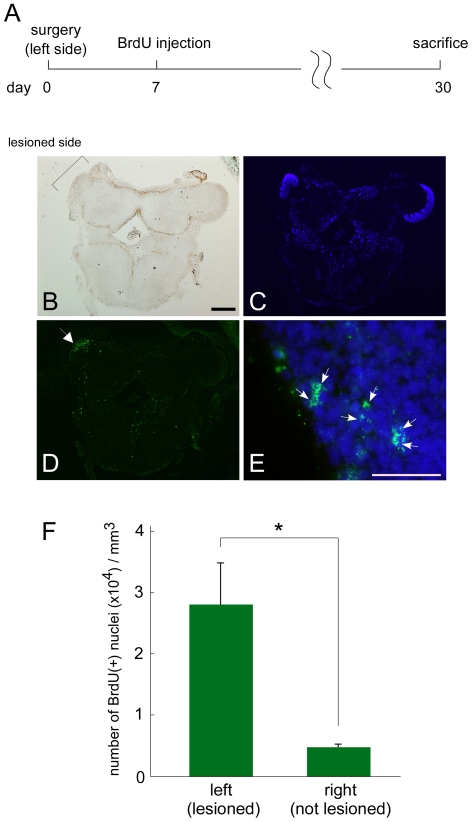
BrdU incorporation is enhanced in the lesioned PC.(A) The experimental schedule. (B) Bright field microscopic image of the PC. Scale bar: 500 µm. (C) Nuclear DAPI staining. (D) Immunohistochemical staining of BrdU. An arrow indicates the lesioned (left) PC. (E) Magnified image of the left PC. The BrdU signal and the nuclear staining are green and blue, respectively. Arrows indicate pairs of juxtaposed BrdU labeled cells. Scale bar: 50 µm. (F) Quantification of the densities of the number of BrdU-positive cells in the lesioned (n = 8) and non-lesioned PC (n = 8). *P<0.005 by Student's t-test.